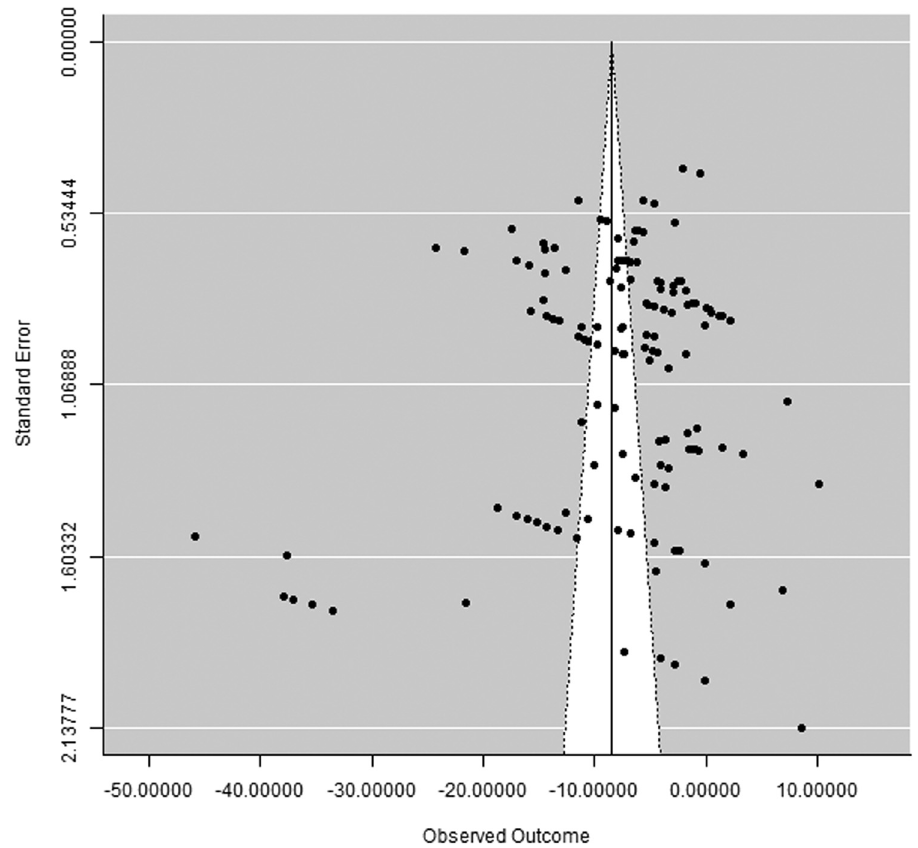
Figure 3: Funnel plots of the impact of cassava intervention on BWG in broiler